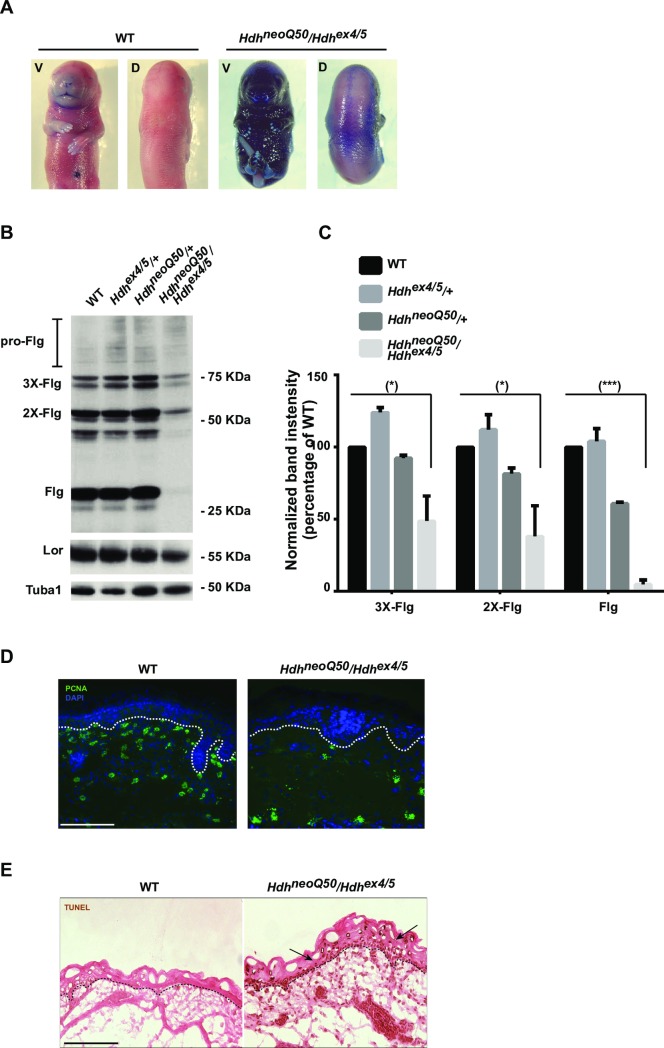
Skin defects in HdhneoQ50/Hdhex4/5 hypomorphic embryos.Representative images of wild-type (WT) and HdhneoQ50/Hdhex4/5 animals, at E18.5. A) At E18.5, following toluidine-blue dye exclusion assay, WT animal shows a functional epidermal barrier but HdhneoQ50/Hdhex4/5 animal has a compromised epidermal barrier on the ventral surface. B) Immunoblot analyses of WT, Hdhex4/5/+, HdhneoQ50/+ and HdhneoQ50/Hdhex4/5 skin protein extracts (E18.5). Bands of Pro-filaggrin (pro-Flg, 2X-Flg, 3X-Flg) at 50–70 KDa and higher molecular weight bands and processed filaggrin (Flg) at 27 KDa were detected in all samples but were decreased in HdhneoQ50/Hdhex4/5 extracts. The bands of Loricrin (Lor) and alpha-tubulin (Tuba1) were similar in all samples. C) Bar graphs summarizing skin-extract protein immunoblot band signal-intensity (relative to WT), expressed as standard deviation of 3 biologic replicates using 2 mice each, as quantified by Image J software. Unpaired t-test. P value < 0.05 (*), P < 0.0001 (***). D) Representative images of cryostat-sectioned skin tissue, with DAPI stained nuclei to show reduced staining of the PCNA proliferation marker in HdhneoQ50/Hdhex4/5 skin. Green = PCNA staining; Blue = DAPI-stained nuclei. Dashed lines depict the cornified basal epidermal layer. All images were taken using a fluorescent 20X objective. Scale bars: 50μm E) Representative images of cryostat-sectioned skin tissue stained with TUNEL assay to quantify apoptotic cell death (arrows) in WT and HdhneoQ50/Hdhex4/5 embryos. Dashed lines depict the cornified basal epidermal layer. All images were taken using a phase-contrast 20X objective. Scale bars: 50μm.